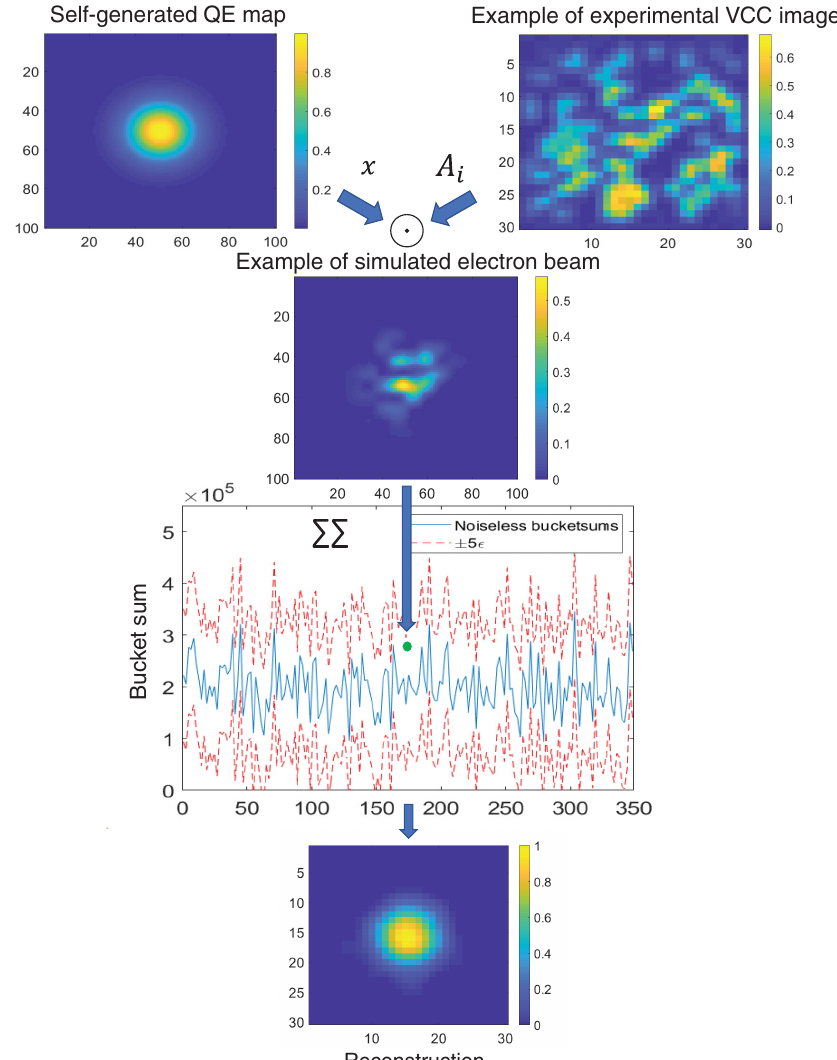
FIG. 9. Overview of simulation using UCLA experimental data. An example of an experimental VCC image (top-right), a user- generated QE map (top-left) and simulated electron beam (top-middle) are shown. Bucket sums are calculated integrating all pixels of the simulated e-beam and adding random Gaussian noise ϵ i , as described by Eq. (A1). Note that the VCC image is upsized to match the size of the QE map. The bottom-middle plot shows example simulated bucket sums for all random scan measurements. The blue line shows the “ noiseless ” bucket sums and the red dashed line shows boundaries of (cid:2) 5 ϵ within which the simulated bucket sums are contained. An example reconstruction using an experimental SNR of 7.8 and N ¼ 350 random masks is given at the bottom. The reconstruction is the same size as the original VCC